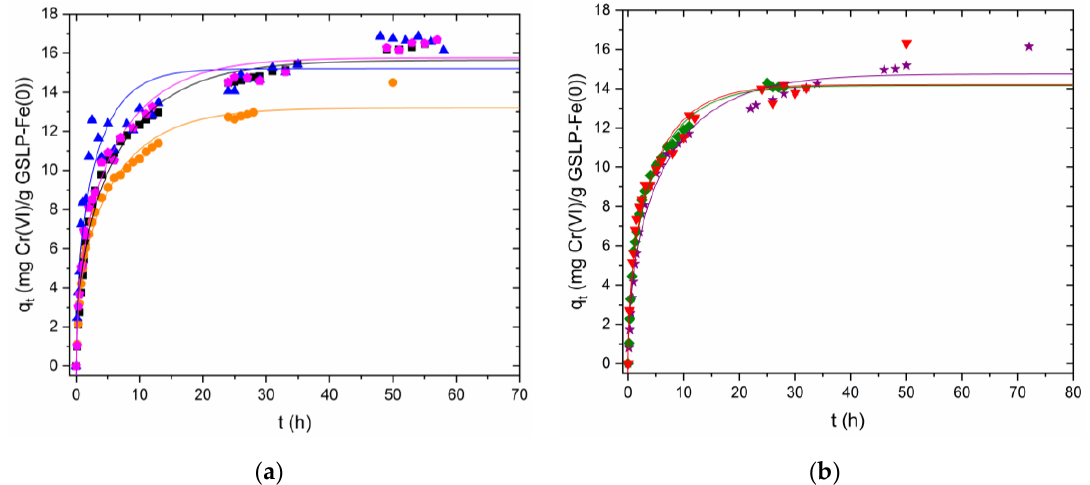
Figure 6. ( a ) Kinetic experimental data for Cr(VI) removal by GSLP-Fe(0) D3 fitted using the nonlinear Boyd model. The GSLP-Fe(0) D3 dose was 2 g·L − 1 , equaling 27.8 mg·L − 1 of Fe, and room temperature and stirring at 200 RPM were used for all experiments. All experiments were acidified using HCl 4M. ( ■ ) pH ≈ 1.2, initial Cr(VI) concentration: 50 mg·L − 1 ; ( ● ) pH ≈ 0.8, initial Cr(VI) concentration: 50 mg·L − 1 ; ( ⬟ ) pH ≈ 0.8, initial Cr(VI) concentration: 75 mg·L − 1 ; ( ▲ ) pH ≈ 0.8, initial Cr(VI) concentration: 100 mg·L − 1 . ( b ) Kinetic experimental data for Cr(VI) removal by GSLP-Fe(0) D2 fitted using the Boyd model. The GSLP-Fe(0) D2 dose was 2 g·L − 1 , equaling 32.5 mg·L − 1 of Fe, and room temperature and stirring at 200 RPM were used for all experiments. All experiments were acidified using HCl 4M. ( ★ ) pH ≈ 1.2, initial Cr(VI) concentration : 50 mg·L − 1 ; ( ♦ ) pH ≈ 0.8, initial Cr(VI) concentration: 50 mg·L − 1 ; ( ▼ ) pH ≈ 0.8, initial Cr(VI) concentration: 75 mg·L − 1